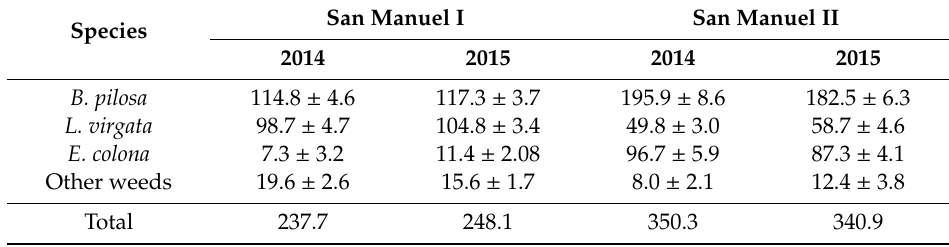
Table 2. Initial weed density (plants m 2 ) in two Persian lime groves of the “San Manuel” Farm, Puebla,